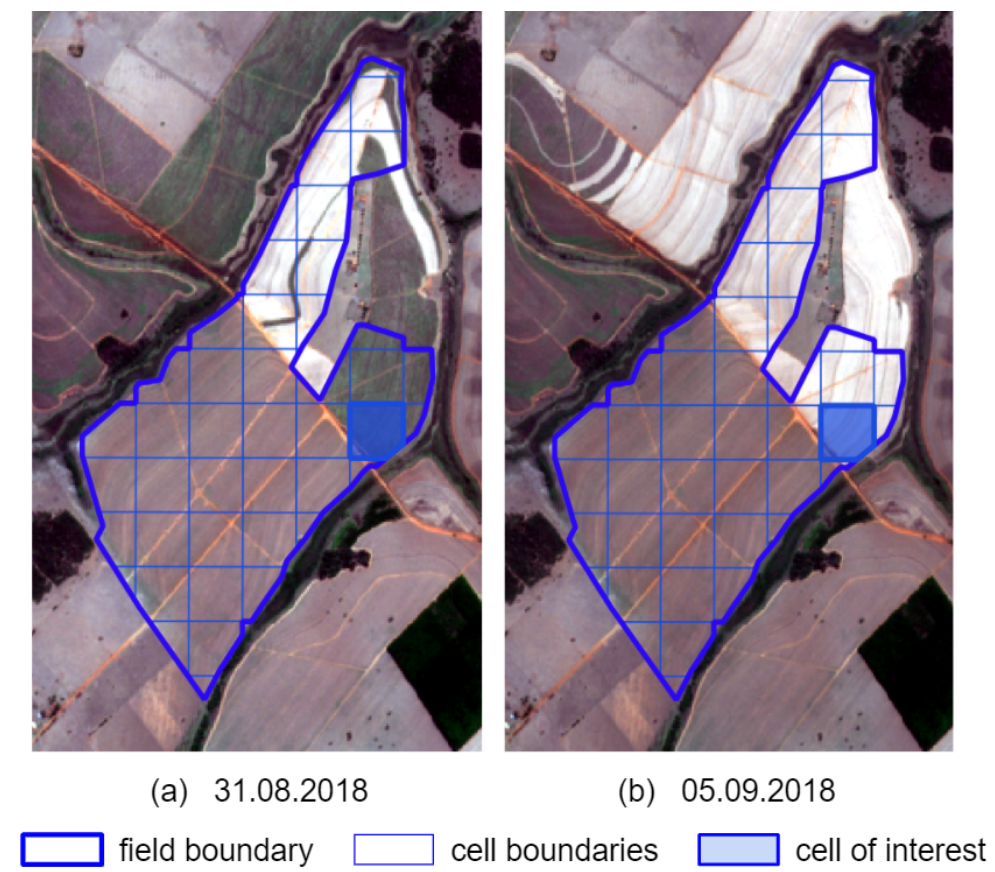
Figure 23. Example of the parcel with inclusions of a neighbouring field (cid = 516): ( a ) the most of the parcel is not harvested; ( b ) both parts are